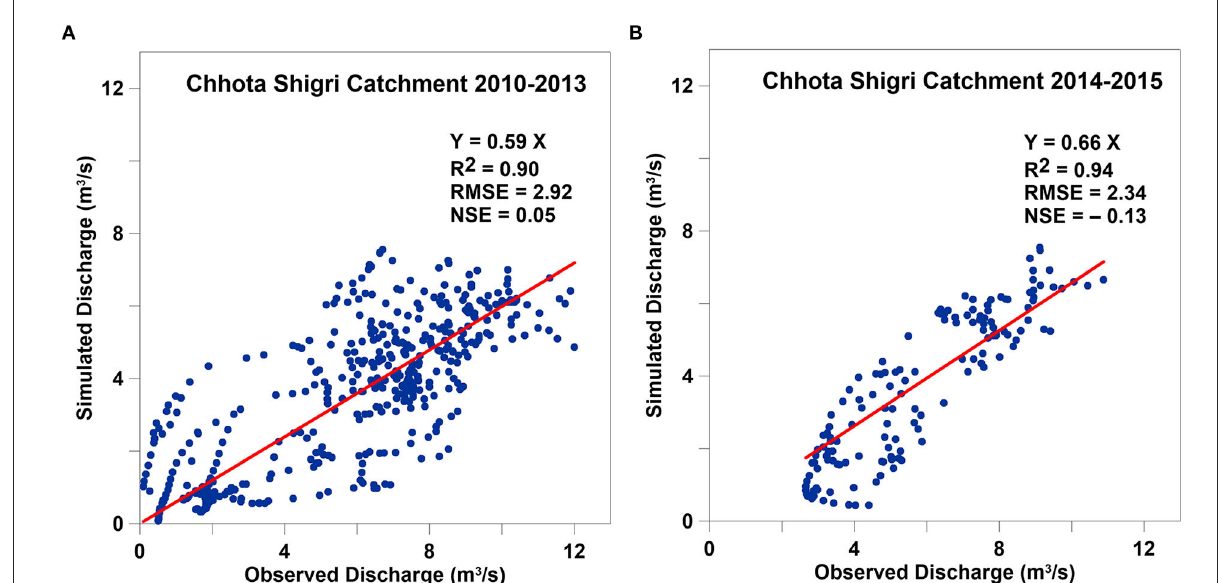
TABLE 2 List of calibrated parameters and their calibrated values for the Chhota Shigri Catchment over 2010–2013 and Chandra-Bhaga Basin over 2004–2006. Parameter Chhota Shigri